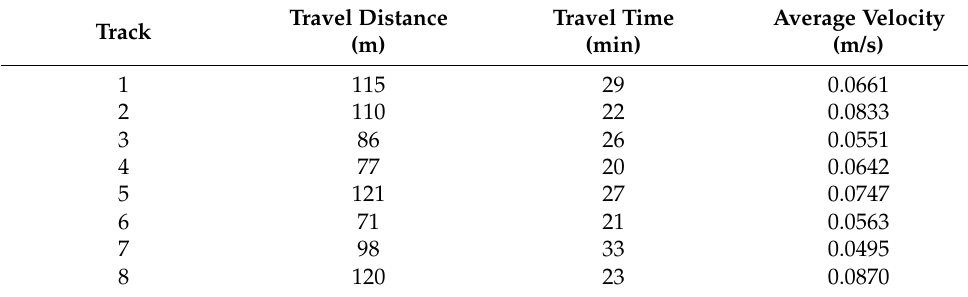
Table 2. The average velocity calculated from GPS drifter experiments.